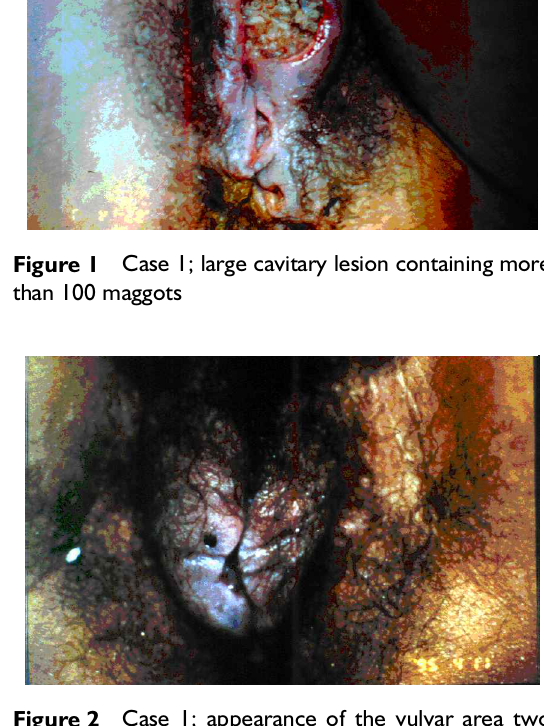
Figure 2 Case 1; appearance of the vulvar area two weeks after surgical cleaning